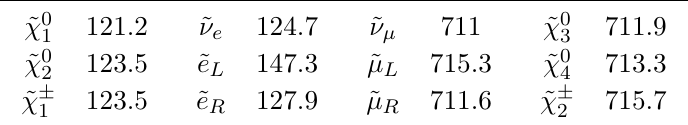
Table 3 . Physical masses in GeV at the benchmark model point BP-2.